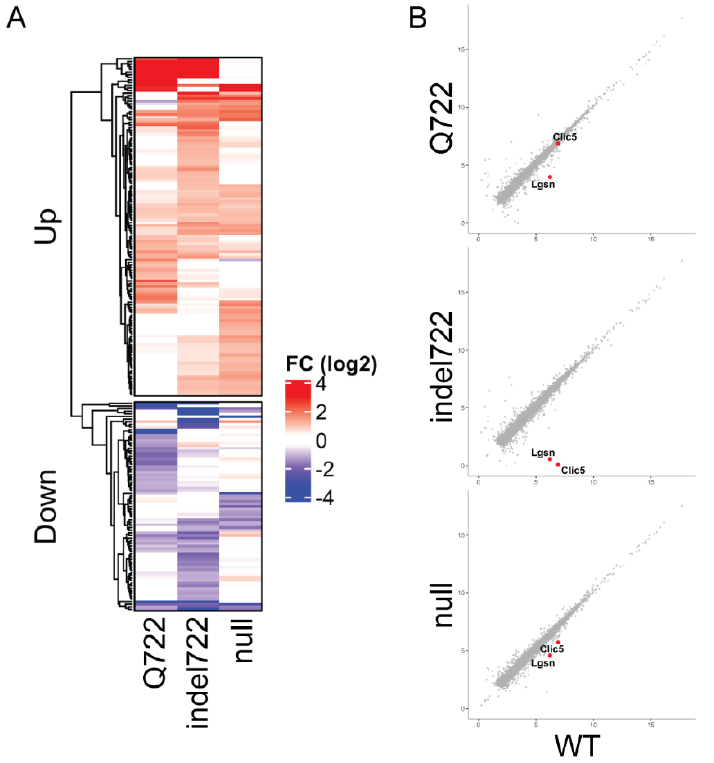
Figure 8. Gene expression changes in Epha2 -mutant and Epha2 -null lenses (P7). RNA-seq analysis identifies unique expression changes in Epha2 -mutant (Q722, indel722) and Epha2 -null lenses com- pared to wild type ( A ). Genes known to be involved in lens cell differentiation, Lgsn and Clic5 , show varied downregulation across Epha2 genotypes ( B